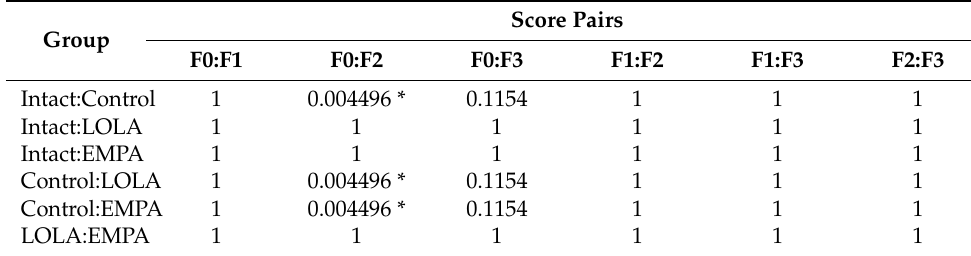
Table A5. Adjusted p -values for METAVIR-F score frequency distributions. Group